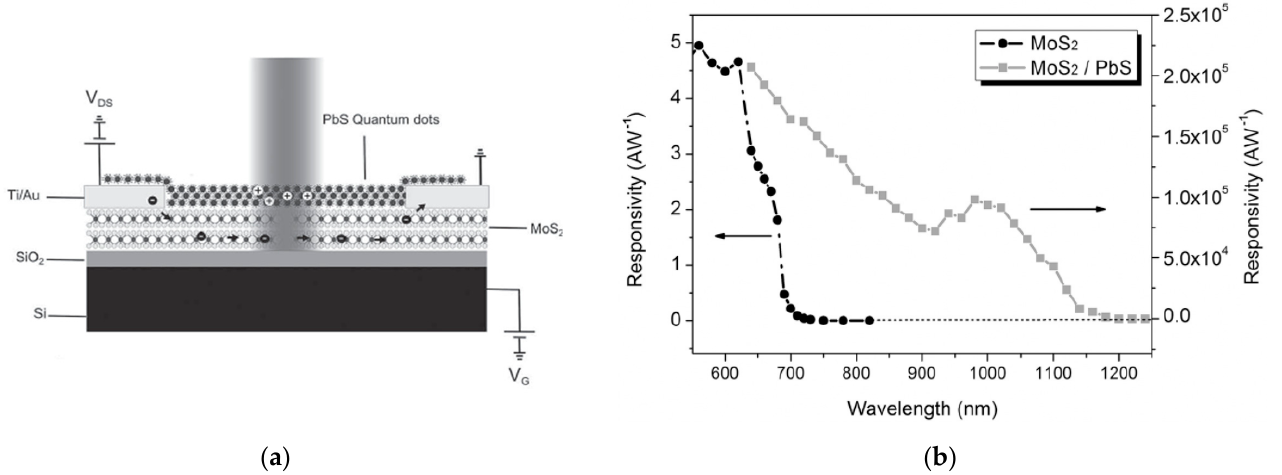
Figure 13. ( a ) Representation of a phototransistor based on MoS 2 and PbS quantum dots; ( b ) Responsivity of the MoS 2 /Pbs based device compared to the values for the neat MoS2-based device over the visible-NIR spectral range. Reprinted with permission from ref. [32]. © 2014, John Wiley and Sons.